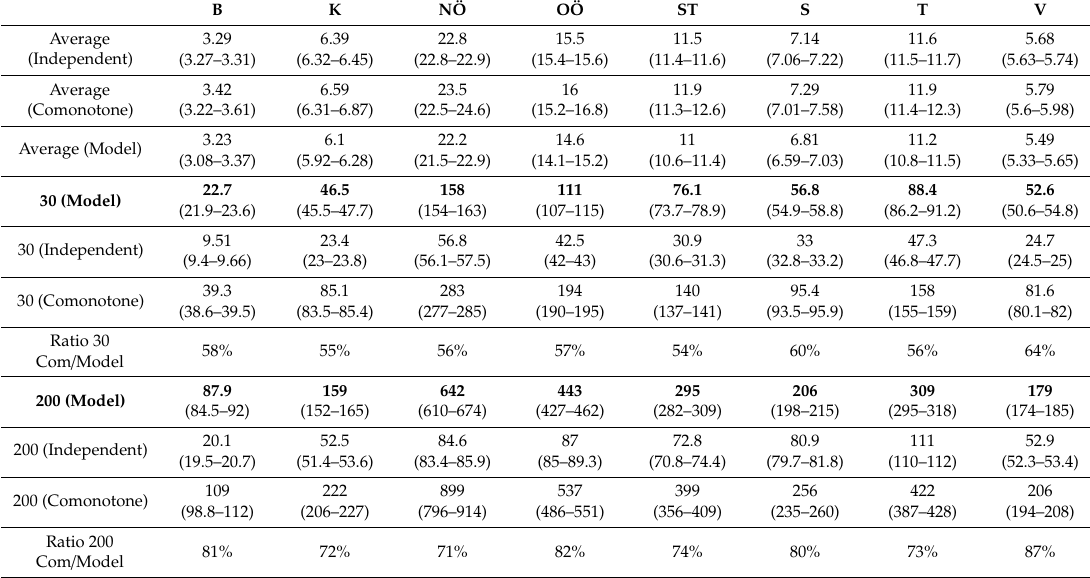
Table 2. Average yearly damage and estimated damage (in mio. € ) for floods with return periods of 30 and 200 years, for the states of Austria. The damage is calculated with the HORA model and with three di ff erent dependence structures between the municipalities (the estimated dependence structure of this paper, independence and comonotone dependence). Numbers in parentheses are the 95% confidence intervals from the Monte Carlo